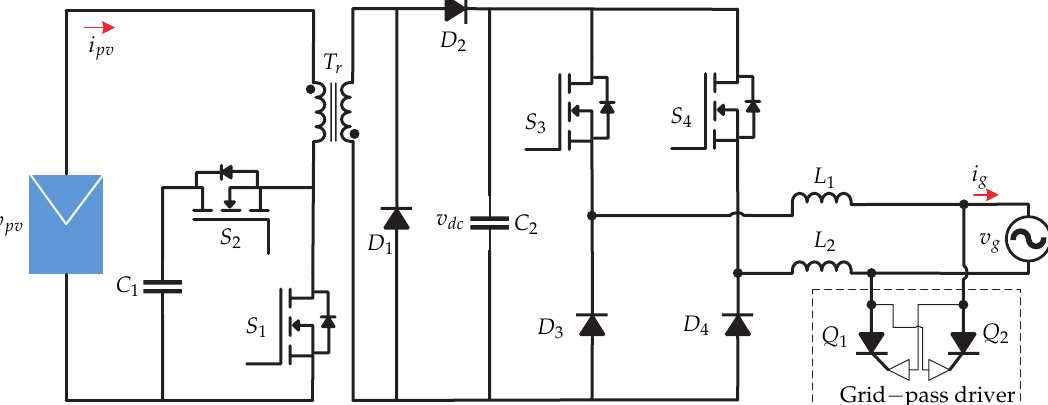
Figure 14. Microinverter’s topology proposed in [25].